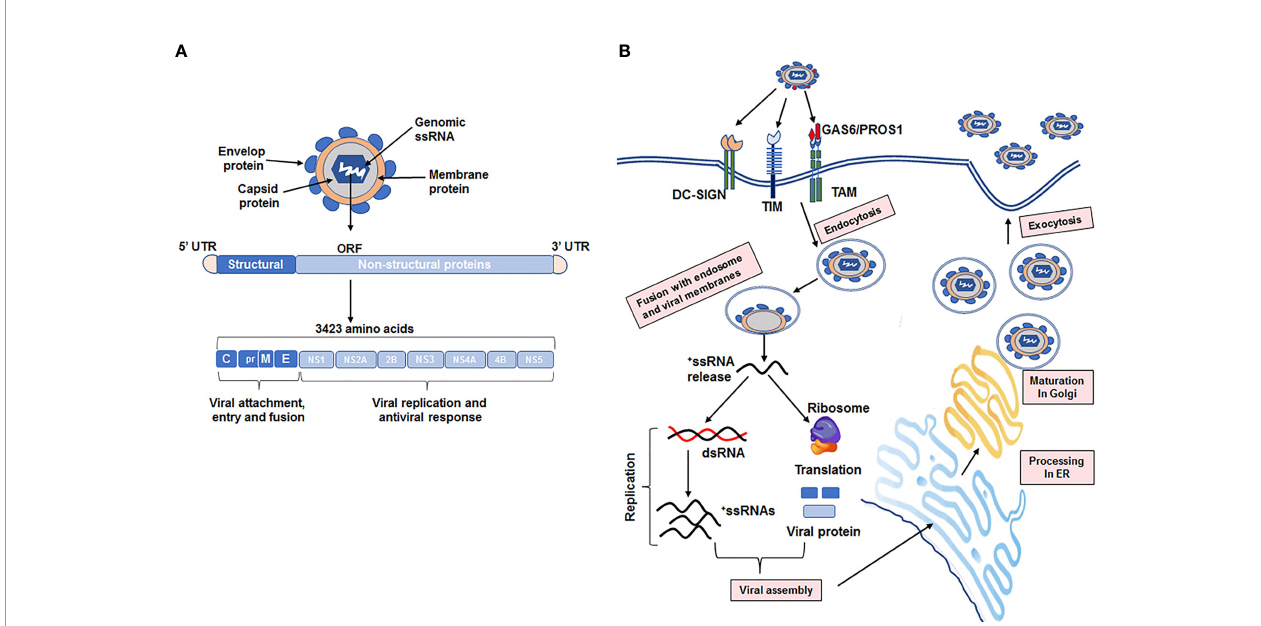
FIGURE 2 | Detailed structure of the ZIKA virus genome, replication, and maturation into host cells. (A) The ZIKA virus (ZIKV) genome is single stranded positive sense RNA, which is approximately 10.7 kilobase in length and contains a single open reading frame (ORF) with two fl anking untranslated regions on the capped 5 ′ - end and the 3 ’ -end lacking a polyA-tail. ORF encodes a single polyprotein comprised of 3423 amino acids, which is post-transcriptionally cleaved by viral and host cell proteases into 3 structural proteins (the capsid (C), precursor membrane (prM), and envelope E) and 7 non-structural proteins (NS; NS1-NS2A-NS2B-NS3- NS4A-NS4B-NS5). Structural proteins mediate viral attachment, entry, and fusion into host cells, whereas non-structural proteins are involved in viral replication and the host antiviral response. (B) Schematic presentation of ZIKV entry, replication, and maturation in host cells. The initial step in ZIKV infection is viral attachment via the viral envelop (E protein and phosphatidylserine; PS) to receptors (DC-SIGN, TIM, and TAM family members) on the host cell membrane. Subsequently, this binding mediates internalization into host cells via clathrin-mediated endocytosis. Then, the viral RNA is released into the host cytoplasm following fusion of viral and host endosomal membranes. The released RNA is immediately bound onto host ribosomes and translated into a polyprotein that is cleaved by viral and host cell proteases to form mature structural and nonstructural proteins. Viral replication is mediated by viral RNA-dependent RNA polymerase and methyltransferase on the surface of the endoplasmic reticulum (ER), resulting in a double stranded (ds) RNA. Transcription and replication of the dsRNA result in the formation of new viral mRNAs and ssRNA genomes, respectively. Following viral assembly of capsid proteins at the ER, the virion is transported to the Golgi apparatus where virion prM protein is cleaved to form the mature M protein. Finally, the host cell releases the mature virus by